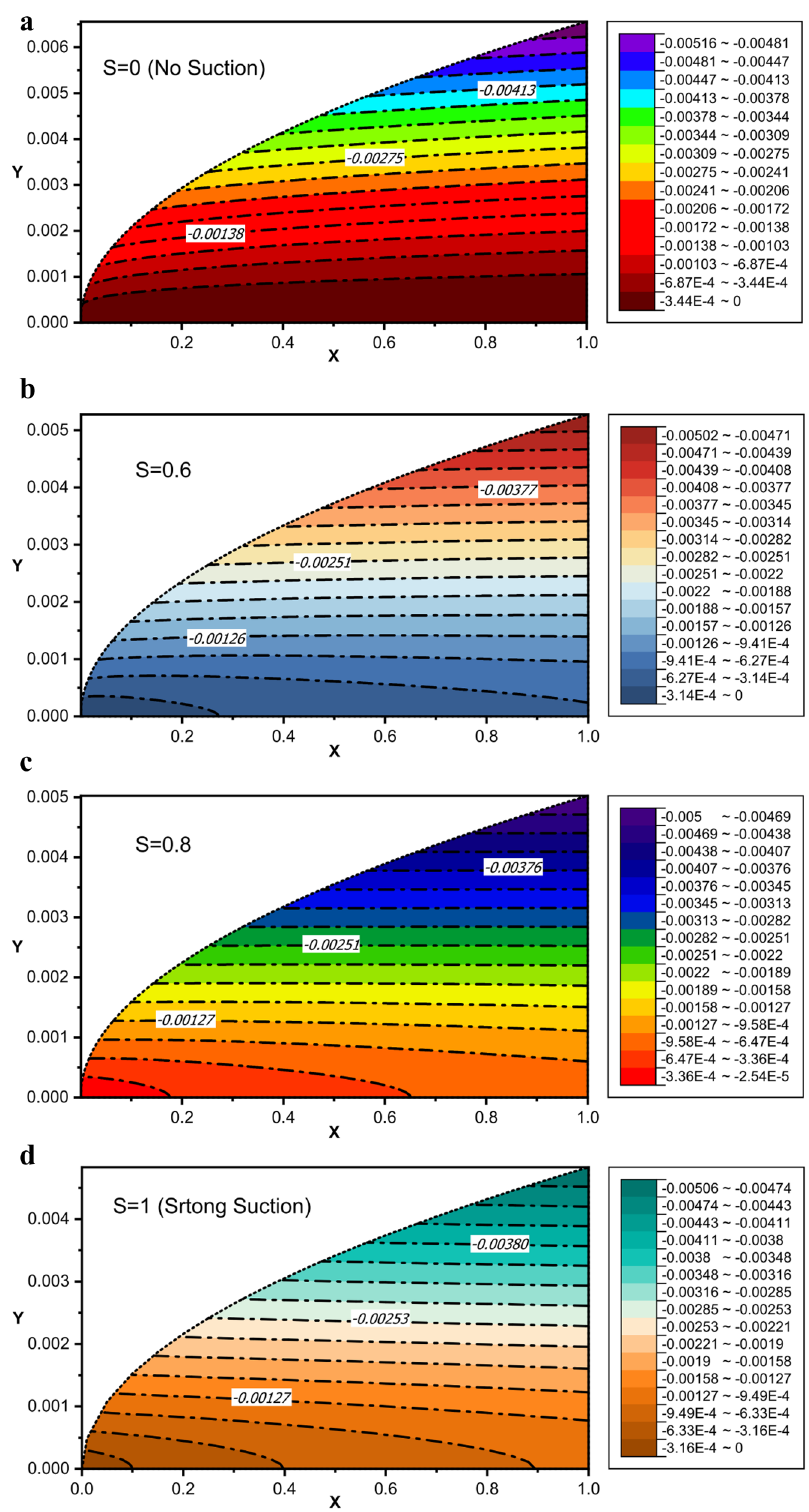
Figure 4. ( a ) Streamline contour without suction or injection ( S = 0 ). ( b ) Streamline contour for S = 0.6 . ( c ) Streamline contour for S = 0.8 . ( d ) Streamline contour for strong suction ( S = 1